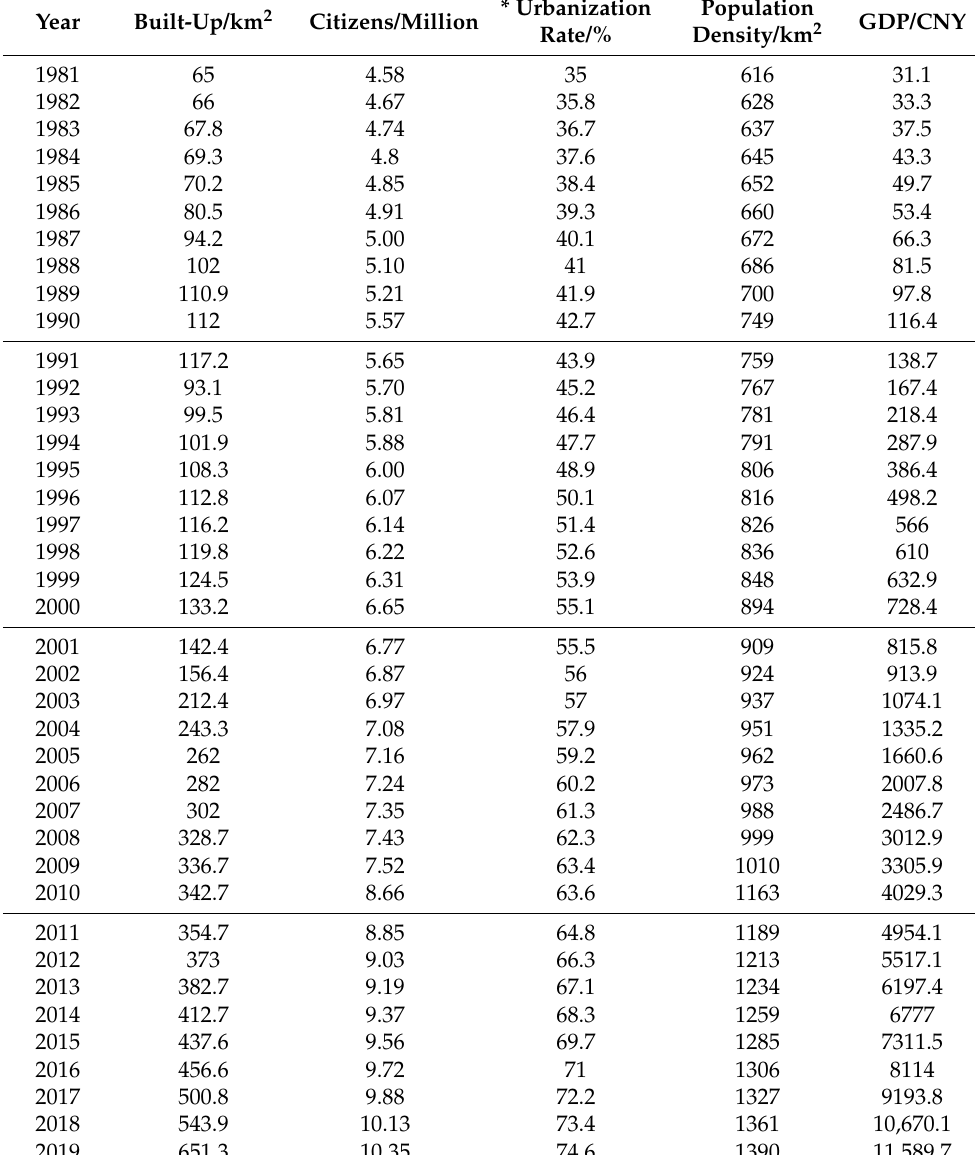
Table A3. Statistics of annual data of urban development in Zhengzhou city from 1981–2019 (data source: Zhengzhou Bureau of Statistics